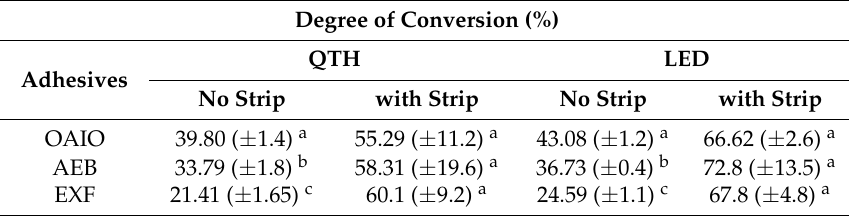
Table 1. Means and SD of the degree of conversion according to the light sources and curing